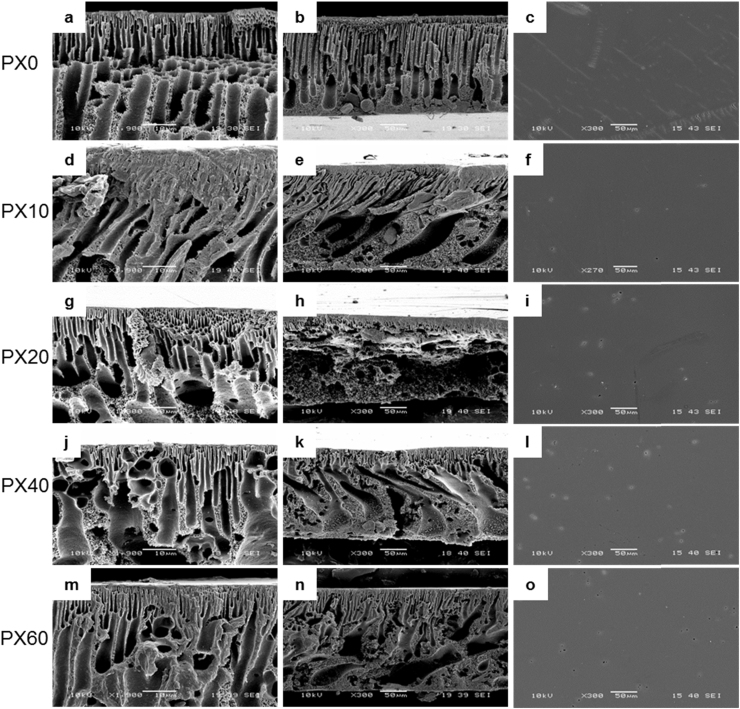
Representative SEM micrographs of flat sheet membrane cross-sections and surfaces. (a, b, c) PX0, (d, e, f) PX10, (g, h, i) PX20, (j, k, l) PX40 and (m, n, o) PX60. Scale bars of left hand column represent 10 µm; scale bars of middle and right represent 50 µm.